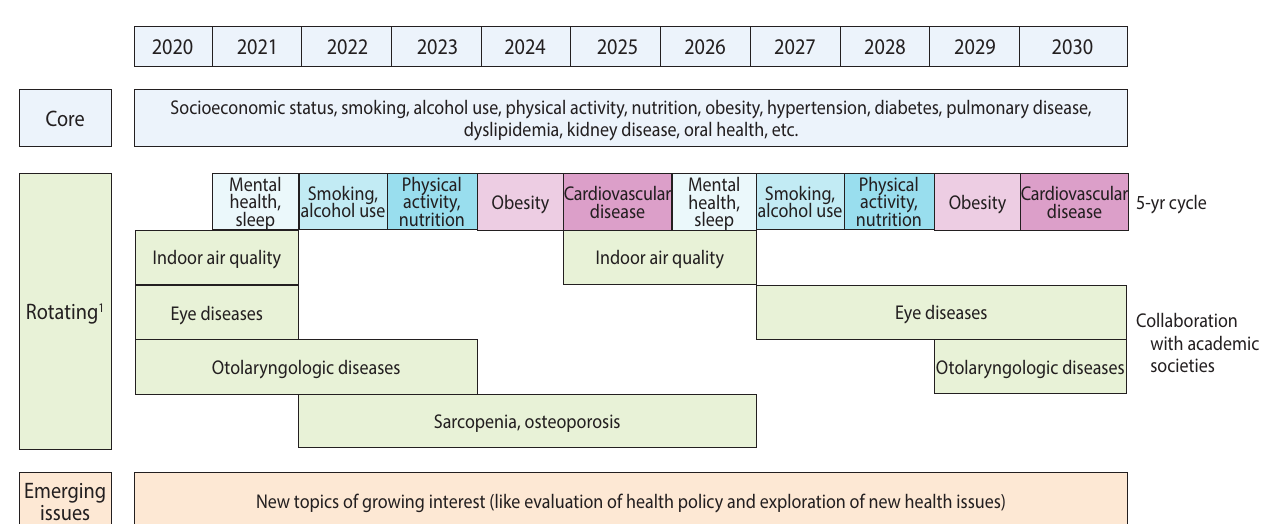
Figure 2. Survey components of the Korea National Health and Nutrition Examination Survey. 1 Rotating items may be changed by plan